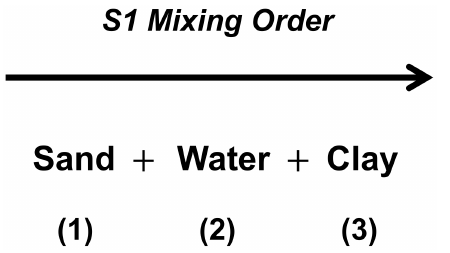
Figure 2. The S1 mixing scheme: sand-distilled water-clay. Table 2. The liquid limit of sand–clay mixture as a function of clay content. K Clay Content (%)